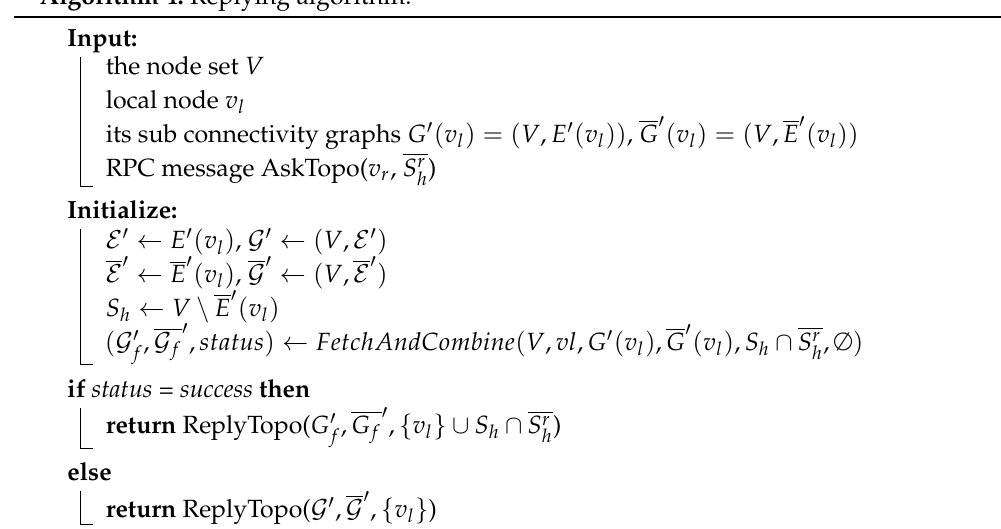
Algorithm 4: Replying algorithm.